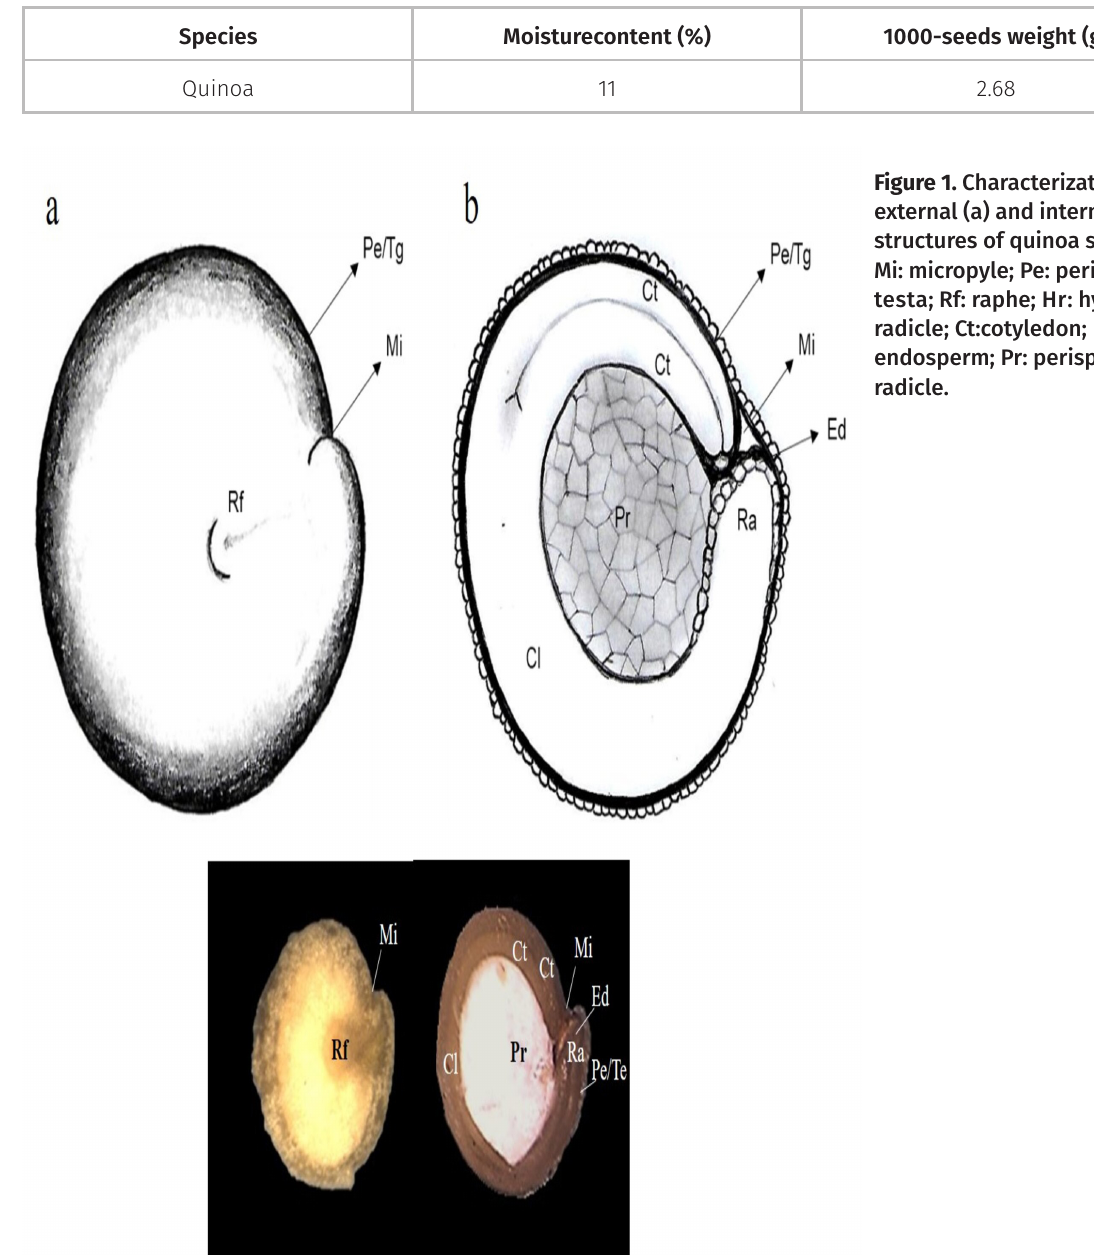
Table II. Moisture content (%) and 1000-seeds weight (g) of quinoa seeds ( Chenopodium quinoa Willd.).